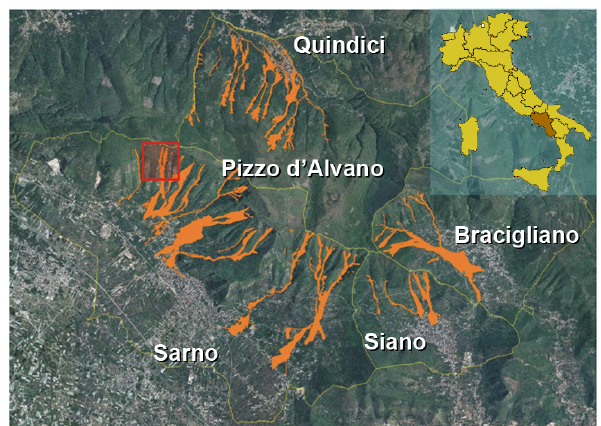
Figure 1. Overview of the Pizzo d’Alvano Massif and the area af- fected by the May 1998 mudflows. The red square delimits the area where the SUSHI model has been